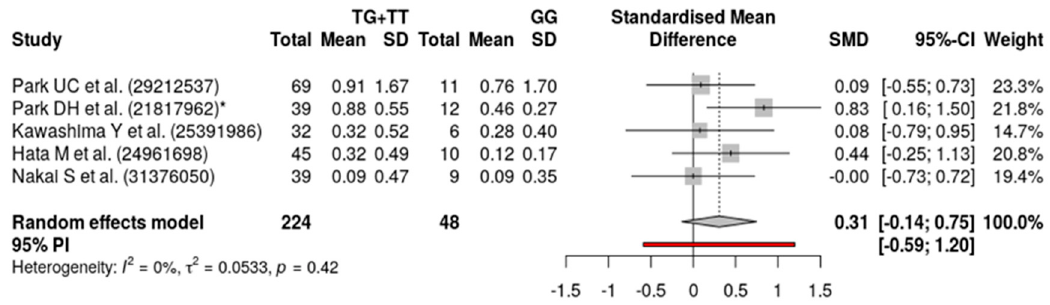
Figure 2. Forest plot of the meta-analysis showing the association between ARMS2 A69S (rs10490924) and treatment response to anti-VEGF agents in PCV patients using random-effects models. Recessive model for allele T (TT vs. TG + GG).